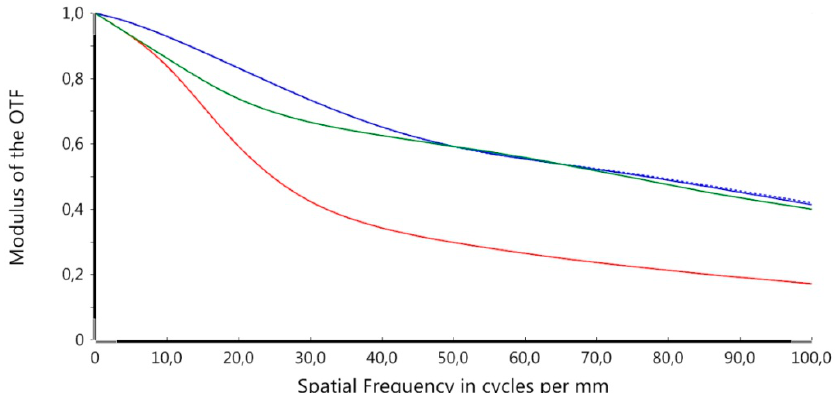
Figure 11. MTF of the nominal configuration and three different refraction power adjustments: − 0.8 dpt (red), 1.5 dpt (blue), and 3.0 dpt (green). ´ 0.8 dpt (red), 1.5 dpt (blue), and 3.0 dpt